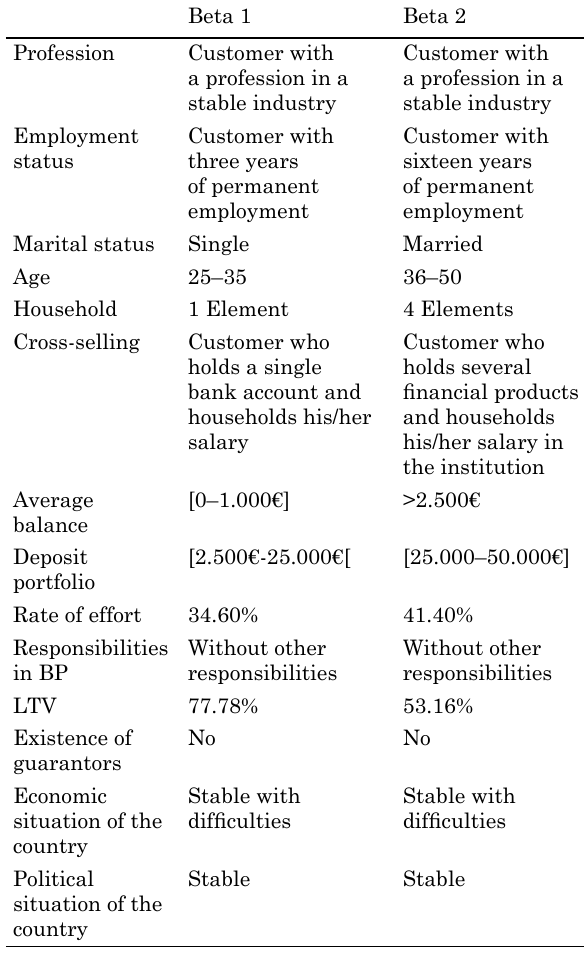
Table 5. Data from two anonymous mortgage